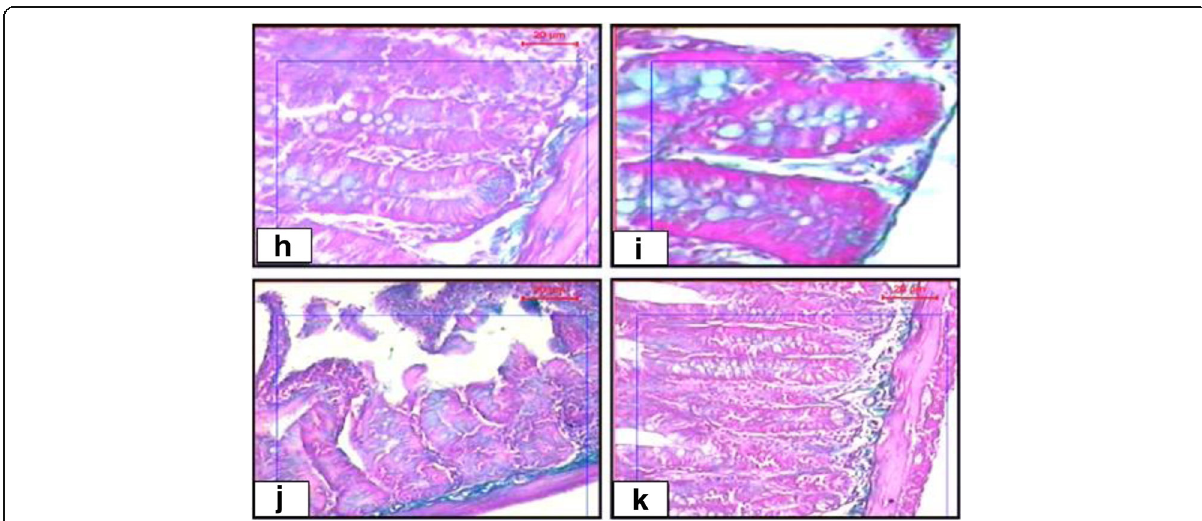
Fig. 4 Photomicrographs of jejunal tissue of the control and treated groups (Masson trichrome). h , i Jejunal mucosa of a control and GABA- treated rat showing normal Paneth cells with its characteristic granules stained greenish blue (×200, ×400). j Jejunal mucosa of IR group showing damaged mucosa with complete disappearance of Paneth cells (×200). k Jejunal mucosa of IR + GABA group showing somewhat normal Paneth cells. However, it appears with fewer granules (×100)